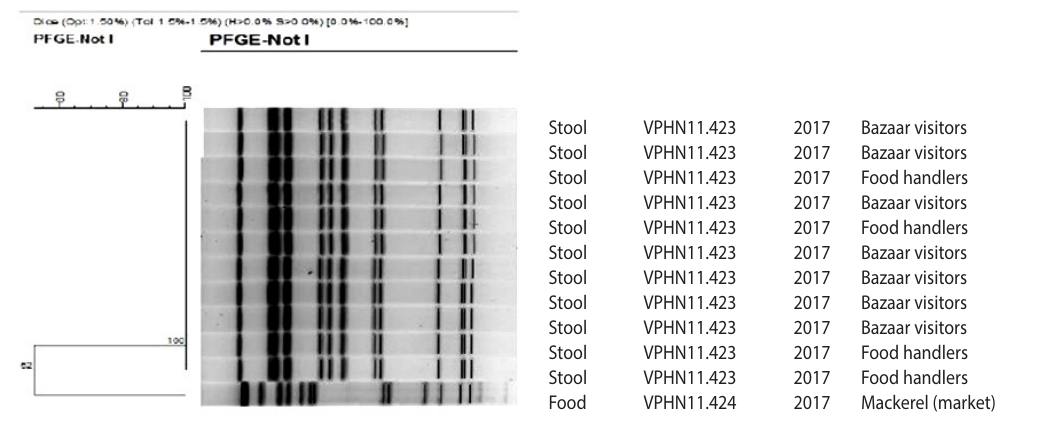
Figure 2. Pulsed-field gel electrophoresis (PFGE) for Vibrio parahemolyticus isolate from outbreak associated with cross-contamination from